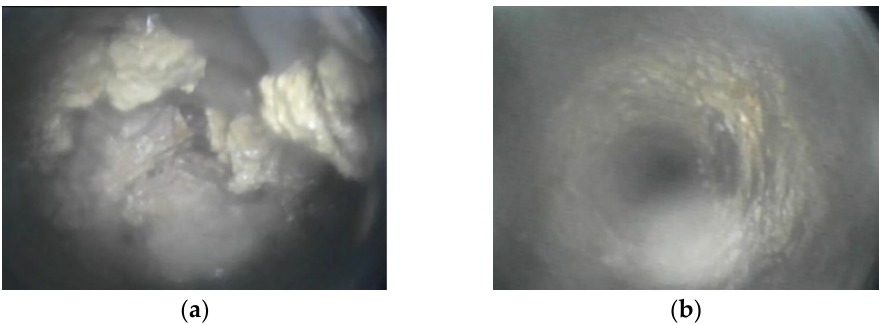
Figure 20. Results of borehole televiewer. ( a ) Before grouting operation. ( b ) After grouting operation.